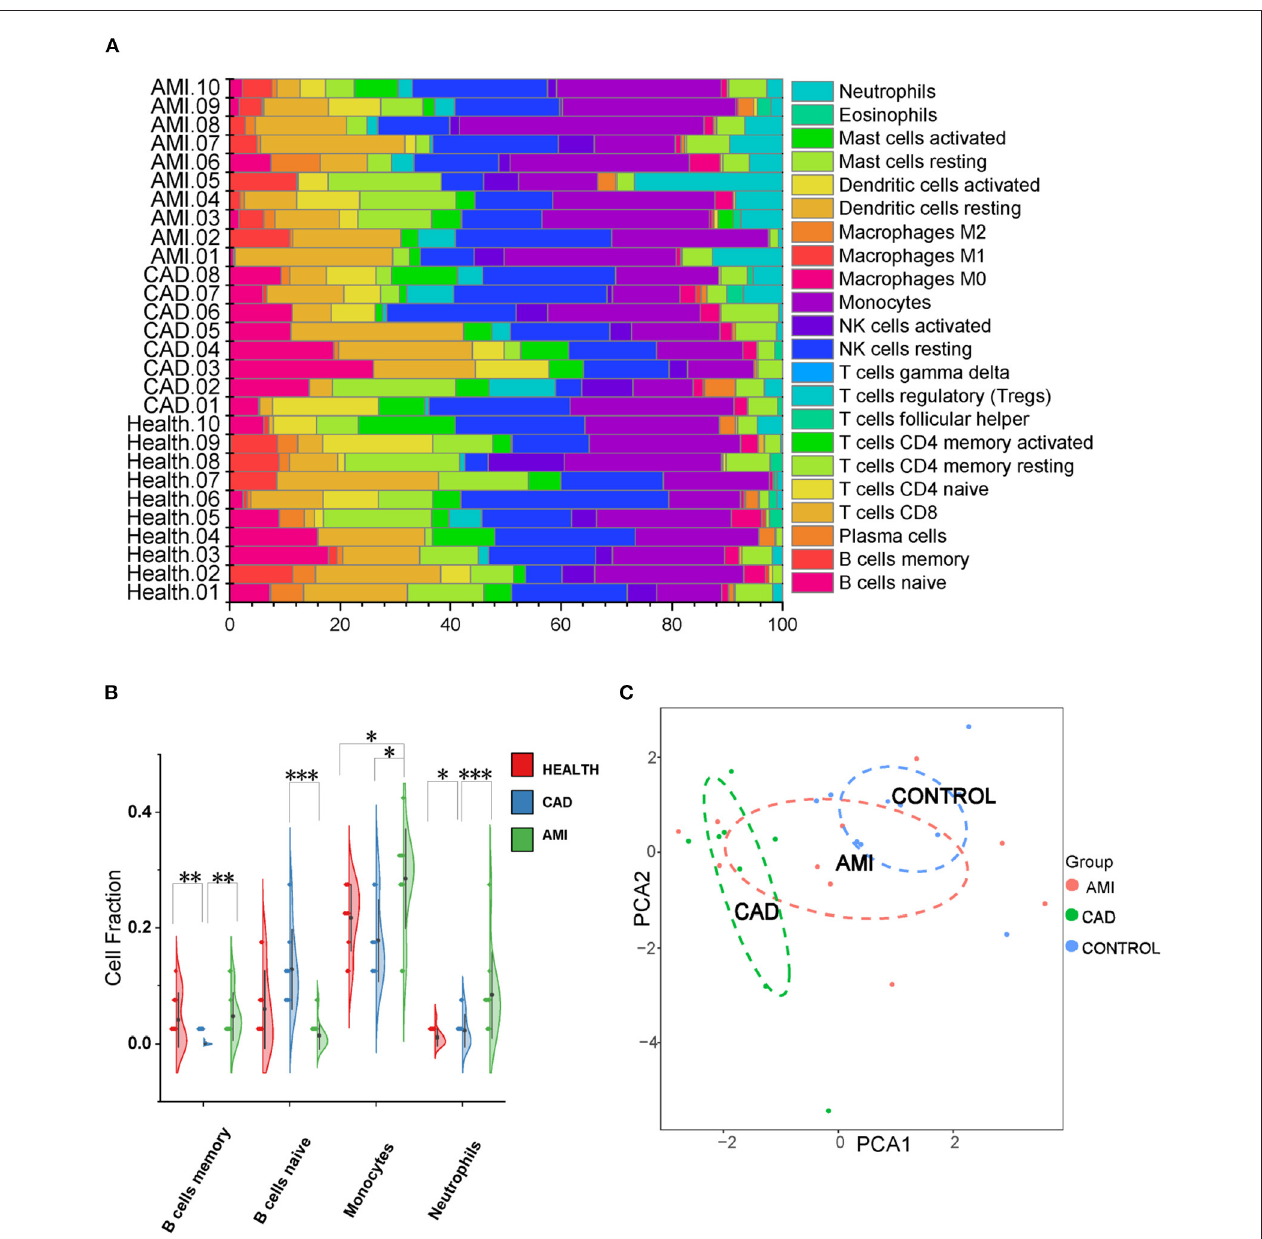
FIGURE 2 | The Exosomal long RNA reflected relative fractions of different immune cell types. (A) Relative fraction of twenty-two types of immunocyte assessed from exosomal long RNA-seq data by CIBERSORT. (B) Violin plot of the fraction of four types of immune cells. Results are presented as the mean ± SD (* P < 0.05, ** P < 0.01, and *** P < 0.001). (C) The PCA of all types of immune cells.